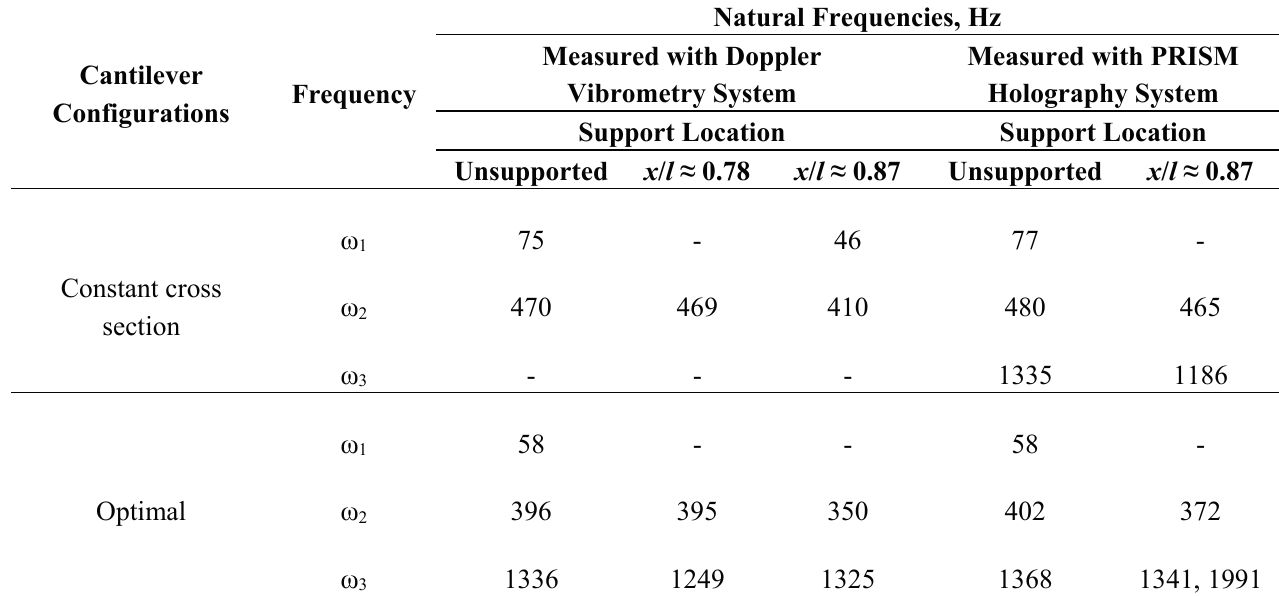
Table 2. Summary of natural frequencies for different cantilever configurations measured with the Doppler vibrometry system and the PRISM holography system.